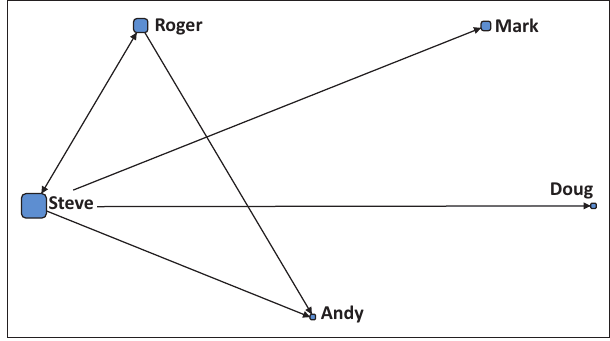
FIGURE 1: Hypothetical example of an organisational network analysis graph showing advise-seeking